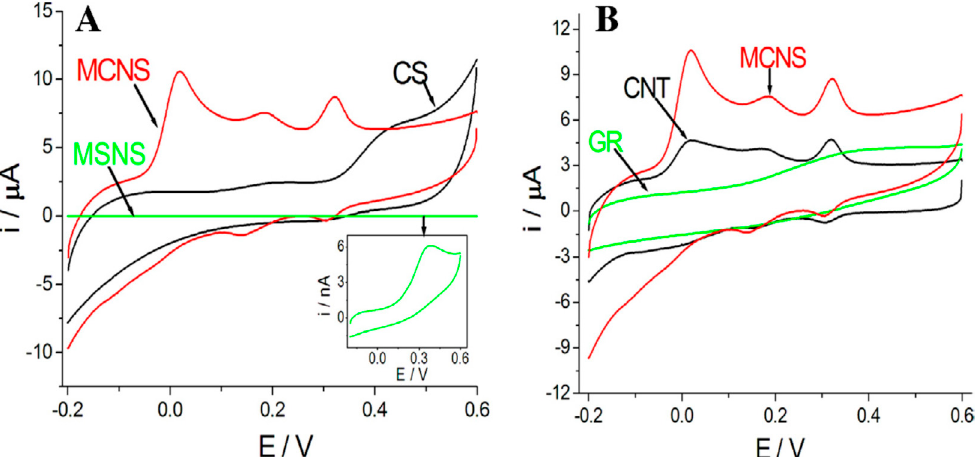
Figure 5. ( A ) Cyclic voltammograms of glassy carbon electrodes (GCE) modified with mesoporous carbon nanospheres (MCNS), non-porous carbon spheres (CS), and mesoporous silica nanospheres (MSNS) in 0.1 M pH 7.4 PBS containing 0.4 mM ascorbic acid (AA), 4 µM dopamine (DA) and 30 µM uric acid (UA). ( B ) Cyclic voltammograms of GCE modified with MCNS, graphene (GR), and carbon nanotubes (CNT) in 0.1 M pH 7.4 PBS containing 0.4 mM AA, 4 µM DA and 30 µM UA (reproduced from [104]).